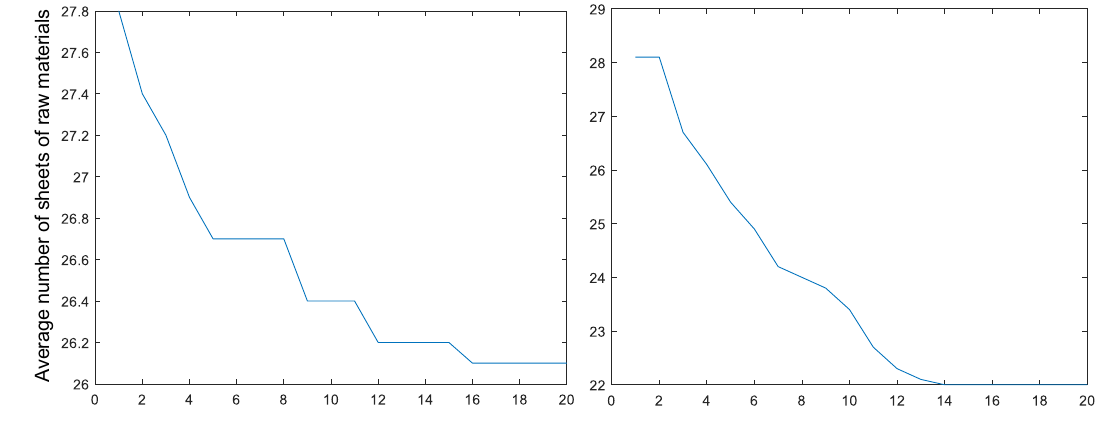
Figure 16. Optimization curves of fitness without (left) and with (right) targeted optimization.